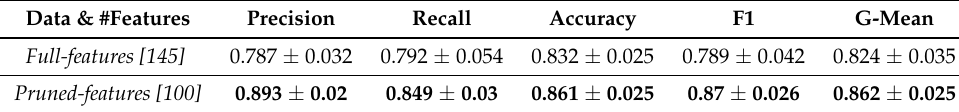
Table 5. Performance of the BBC classifiers in both available datasets.